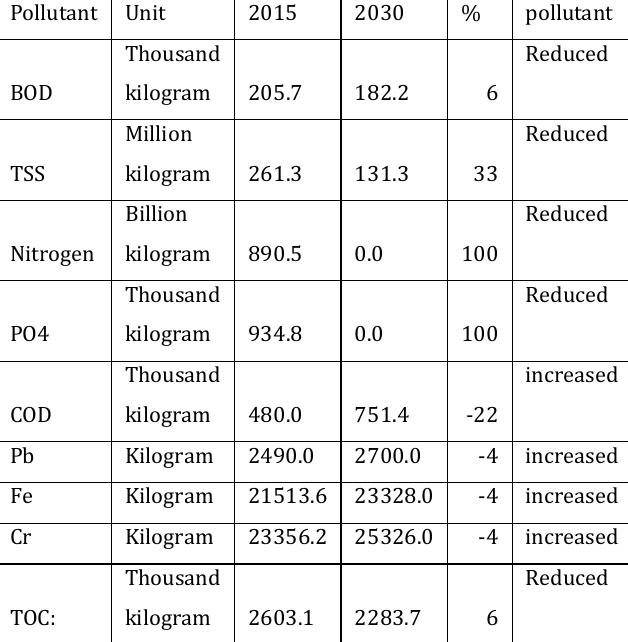
C. Improvement of Pollution Load from Soba WWTP to